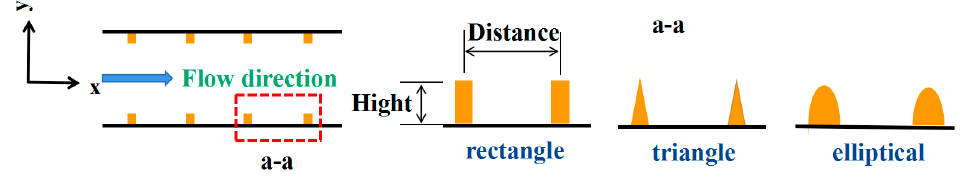
Figure 22. The distribution of standard rough elements in the microchannel.